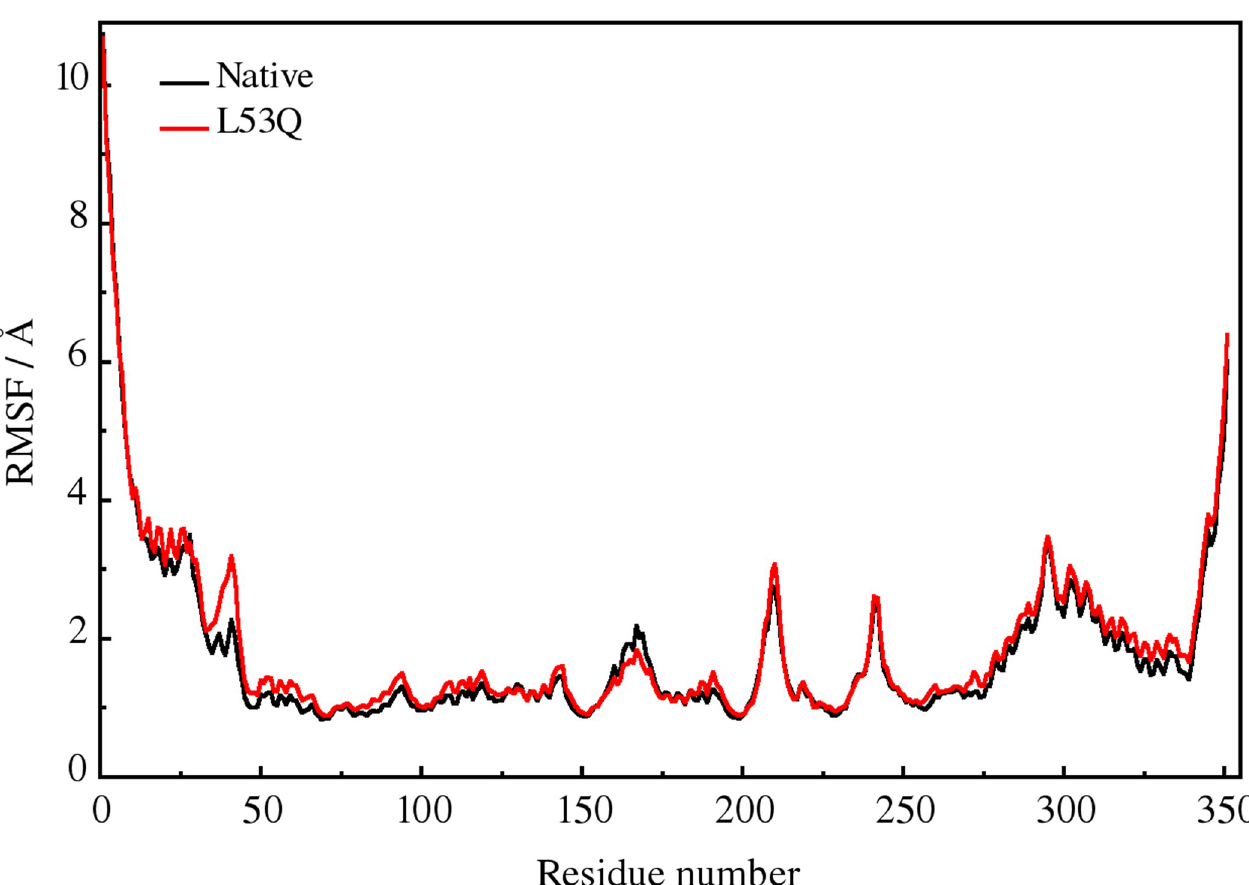
Fig 8. Averages of the RMS fluctuations per residue for the C α atoms during 20 ns MD